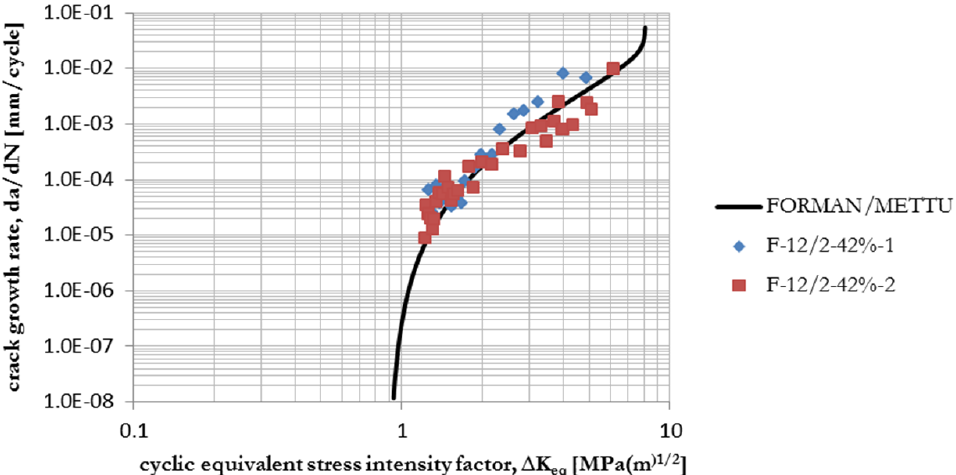
Figure 8: Fatigue crack growth rate data for compact tension specimens (45° fibre direction, R = 0.1).